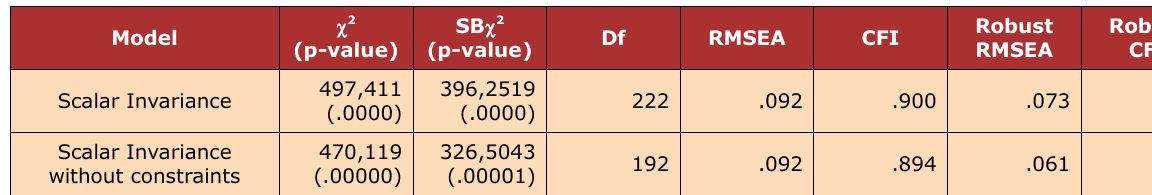
Table 6. Goodness of fit indexes for scalar invariance